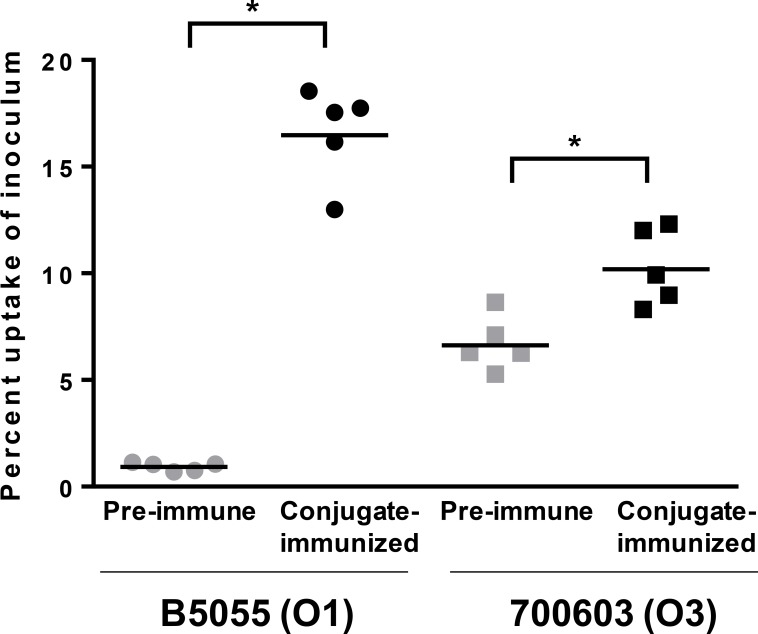
Opsonophagocytic uptake of KP with sera from conjugate-immunized rabbits.The percent uptake of KP B5055 (O1, circles) or 700603 (O3, squares) inoculum into J774 macrophages was assessed after incubation with pre-immune (grey symbols) or conjugate-induced (black symbols) sera from individual rabbits. P value by Mann-Whitney for pre-immune compared to immune sera is indicated. * P ≤ 0.05. Results are the average of duplicate wells for each serum sample and are representative of two independent experiments.